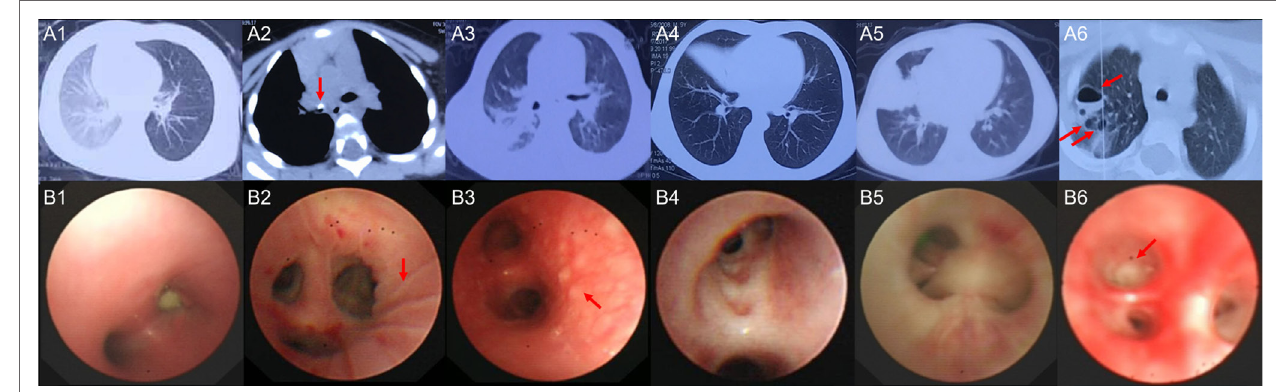
FigUre 1 | The radiological images and bronchoscopic images of the subjects enrolled in sequencing. (a1) shows radiological image of control1, emphysema (air trapping) in the left lung was observed; (a2) shows radiological image of control 3, foreign body (red arrow) blocked the right main bronchus; (a3) shows radiological image of Mycoplasma pneumoniae pneumonia (MPP) 1, patchy density shadows in the right lung were observed; (a4) shows radiological image of MPP3, atelectasis of the right middle lobe was found; (a5) shows radiological image of MPP4, which revealed large density shadows (consolidation) in the right middle lobe; (a6) shows radiological image of MPP6, multiple necrotizing sacs (red arrows) were observed in the right lung. The wall of the sacs was very thin, which was different from the lung abscess; (B1) is the bronchoscopic image of control 2, a peanut was observed in the right main bronchus, which blocked the airway; (B2) is the bronchoscopic image of MPP2, lines on mucosa (red arrow) were observed in the right upper lobe; (B3) is the bronchoscopic image of MPP5, which shows diffused mucosal nodules (red arrow) in distal part of the left main bronchus; (B4) is the bronchoscopic image of MPP6, which shows the erosion of mucosa